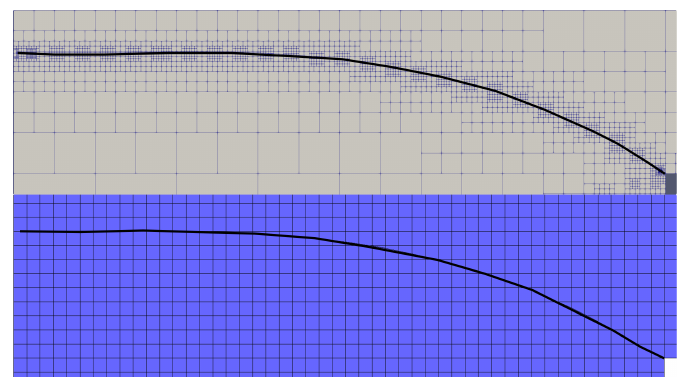
Figure 33. LSP meshes for SBFEM ( top ) and XFEM ( bottom ), with focus on crack path region.